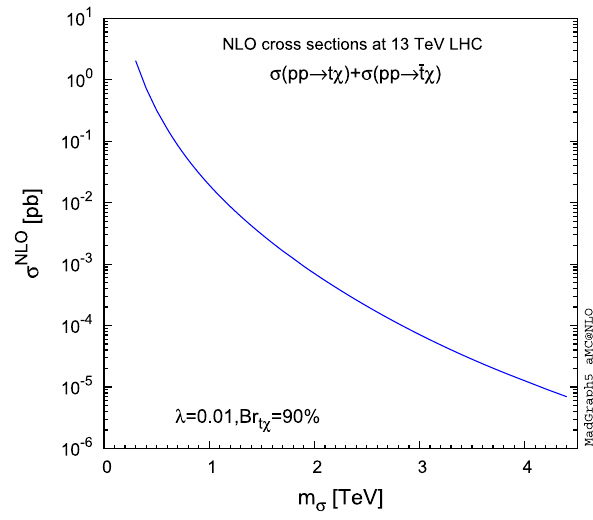
Fig. 8 NLO monotop production cross sections at the LHC operat- √ s = 13 TeV for different m σ values, ing at a centre-of-mass energy assuming m χ = 50 GeV, λ = 0 . 01, BR t χ = 90% and y ≈ 0 . 0977. Varying the mass of m χ from a few GeV to 100 GeV barely affects the value of BR t χ , which is a multiplicative factor entering the monotop production cross